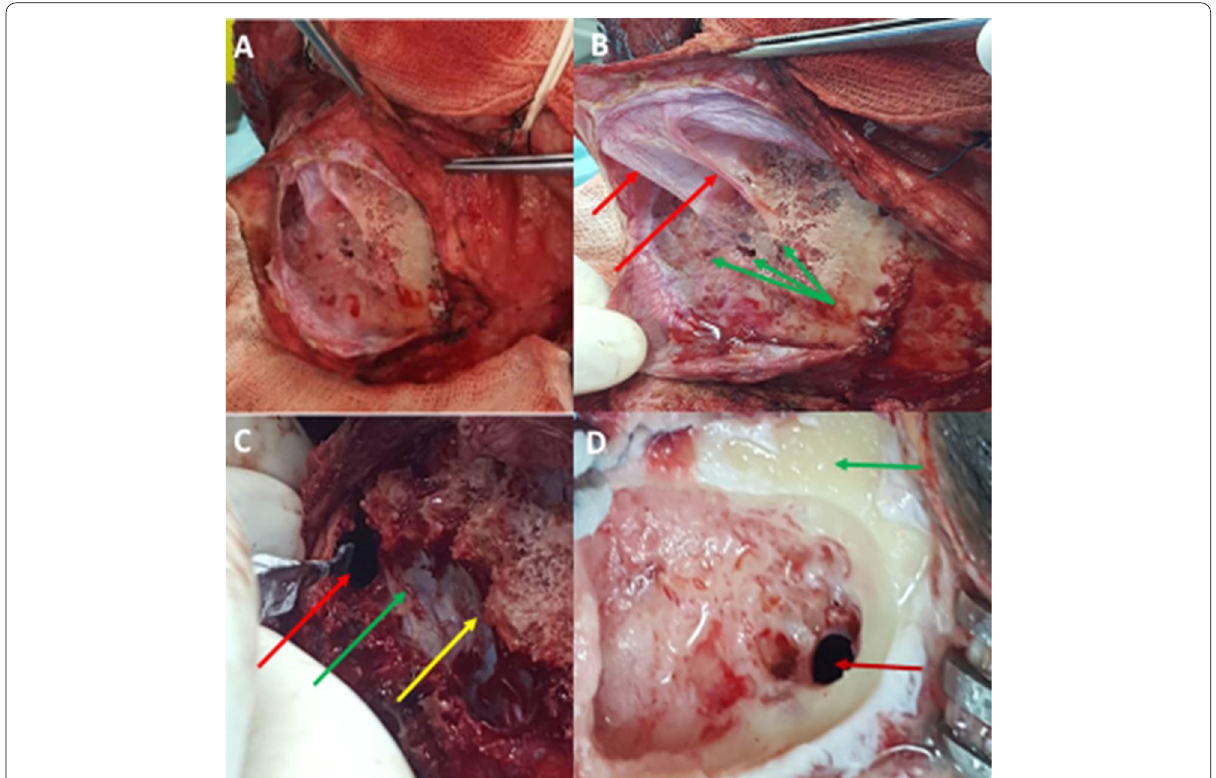
Fig. 5 A , B Operative findings: collapsed pneumatocele after incision of periosteum, trabeculae connecting defective bone (red arrows) with scalp and cribriform like multiple bony defects (green arrows). C Craniotomy with removed lytic skull bones and a dissector being passed from extradural space via a canal “red arrow” to communicate with the mastoid defect in D , green arrow points to the dura and yellow arrow points to the nipped off lytic bone. D Cortical Mastoidectomy of left ear, well circumscribed regular bony defect (red arrow) of inner table of sinudural angle communicating with the extradural space, zygomatic arch is shown by green arrow